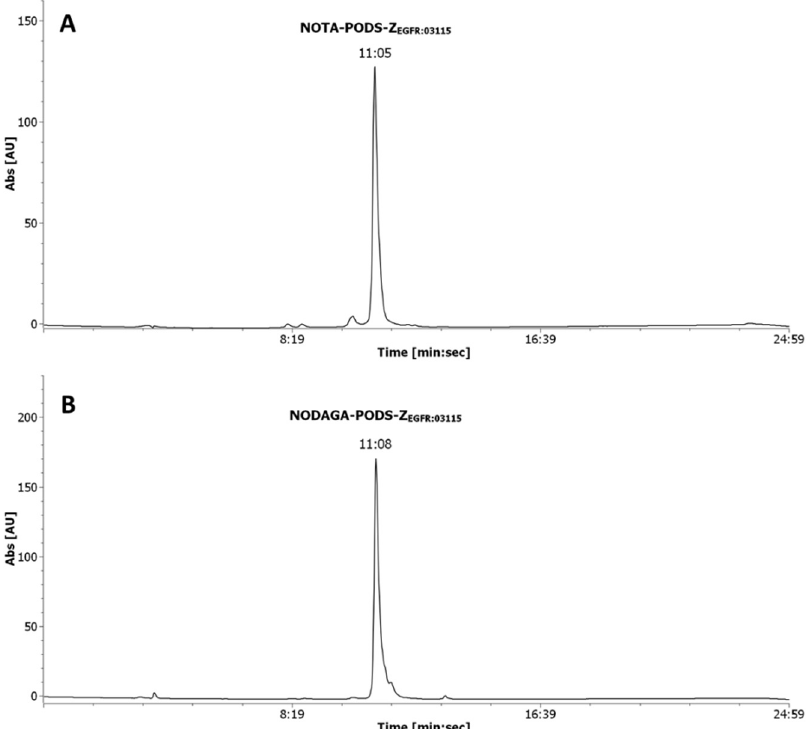
Figure 1. RP–HPLC analysis of NOTA-PODS-Z EGFR:03115 ( A ), and NODAGA-PODS-Z EGFR:03115 ( B ). The absorbance was recorded at the wavelength of 280 nm. The retention time (Rt) is indicated as min:sec.